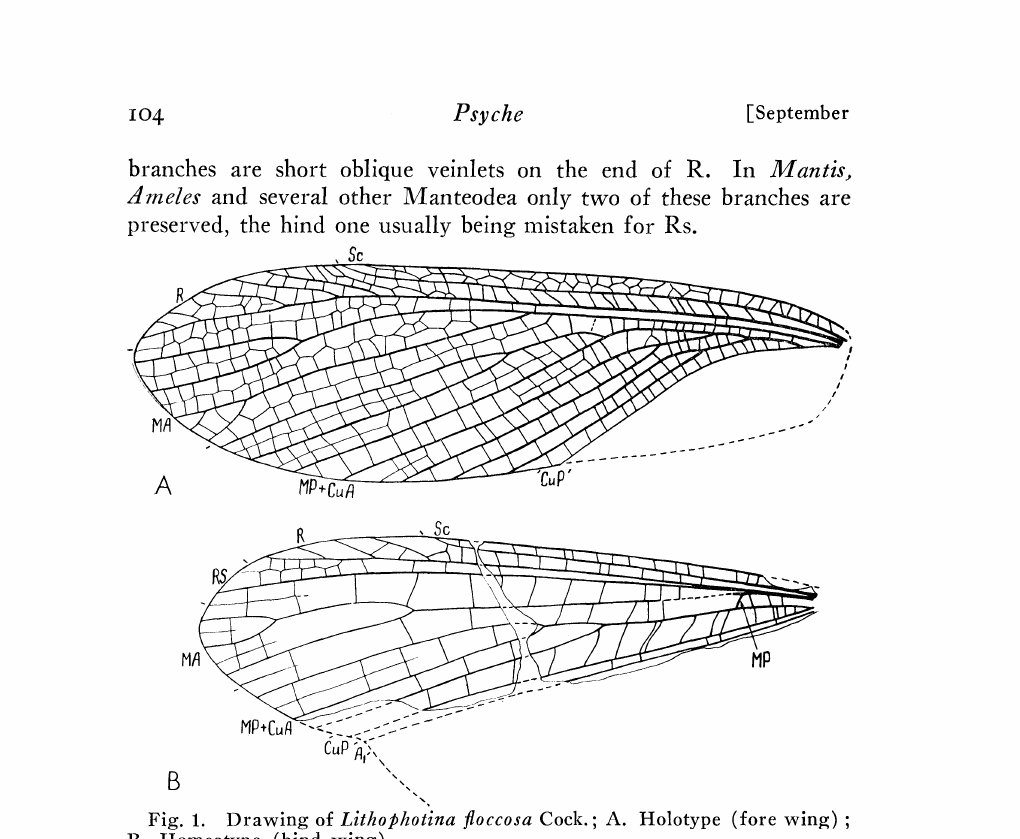
Fig. 1. Drawing o githo_Ib]otina floccosa Cock. A. Holotype (ore wing)" B. Homeotype (hind